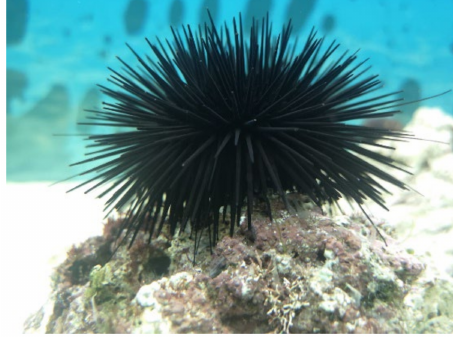
Figure 1. An A. lixula sea urchin